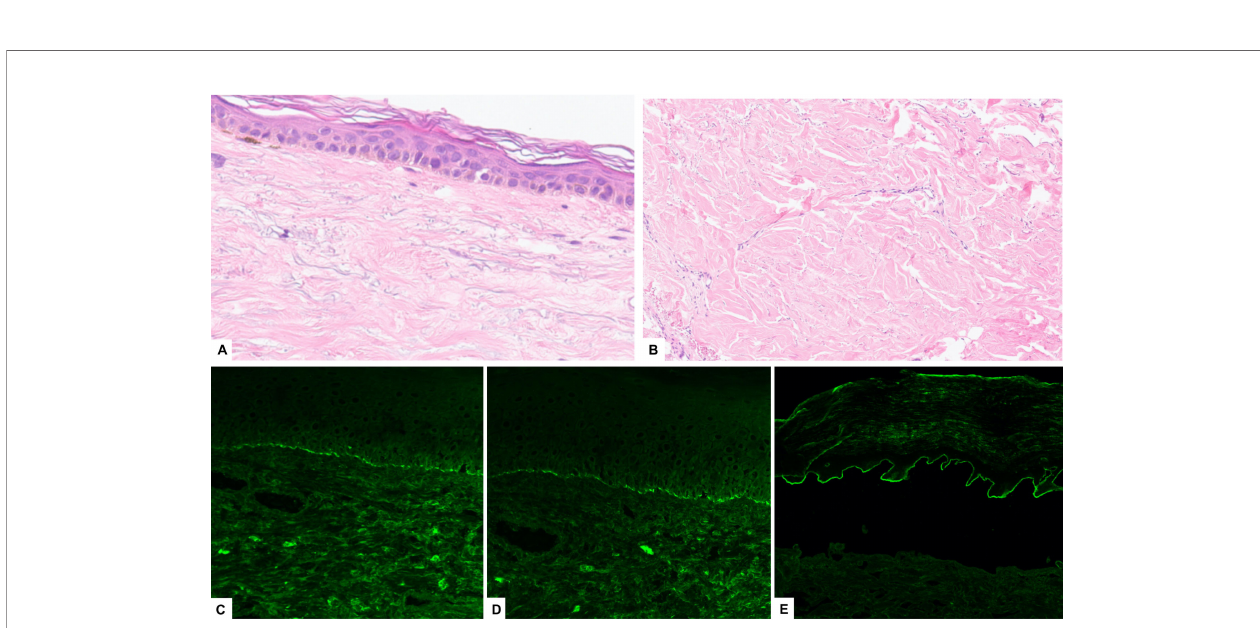
FIGURE 3 | A skin biopsy from an indurated plaque of the trunk showing (A) epidermal atrophy and (B) thickened collagenous bundles in the reticular dermis (H&E). Direct immuno fl uorescence taken from the skin near to an erosion of the upper limb showed linear deposition of IgG (C) and C3 (D) , consistent with a diagnosis of BP; (E) indirect immuno fl uorescence of human salt-split-skin showing IgG deposition along the epidermal side of the basement membrane zone.